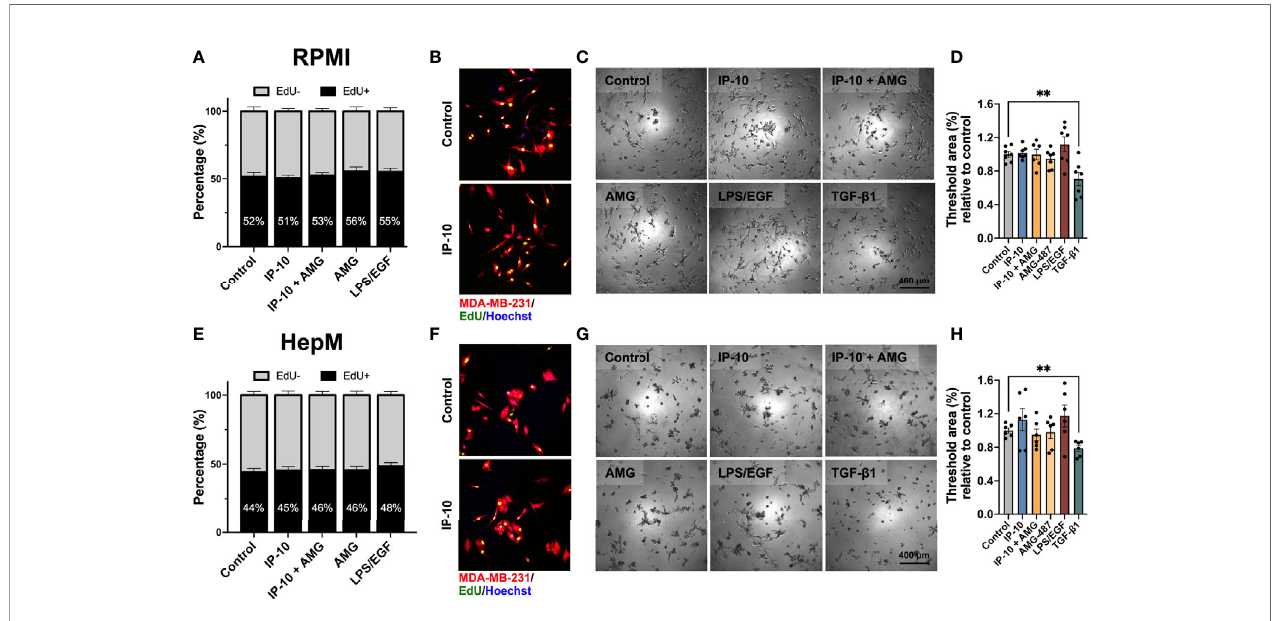
FIGURE 3 | The proliferative activity of breast cancer cells is not directly affected by IP-10. MDA-MB-231 cells cultured in either (A – D) RPMI or (E – H) HepM medium. (A, E) EdU assay for 4 hours to assess proliferation (mean ± SEM; Mann-Whitney test; n = 4). (B F) Representative images of EdU assay. (C, G) Representative images of a dormancy Matrigel ® outgrowth assay after 5 days in culture. (D, H) Quanti fi ed outgrowth (mean ± SEM; Student t-test, ** p < 0.01; n =